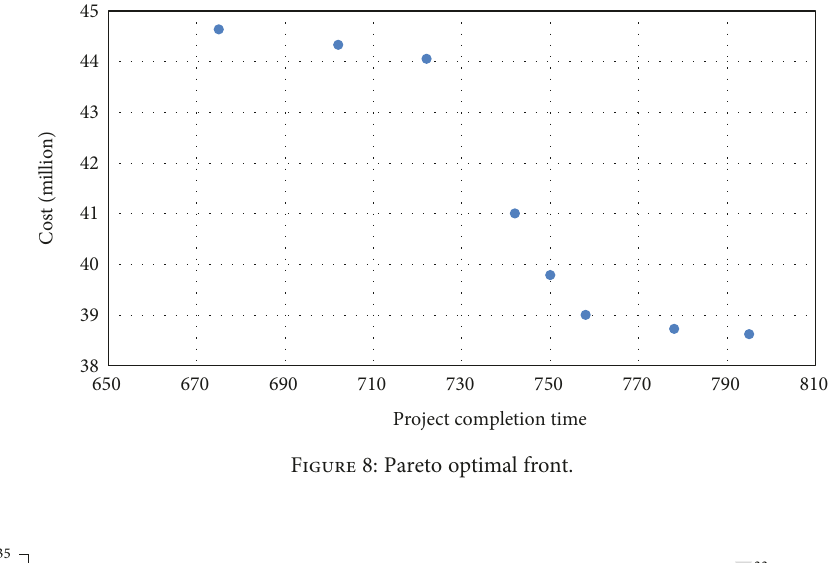
Figure 8: Pareto optimal front.